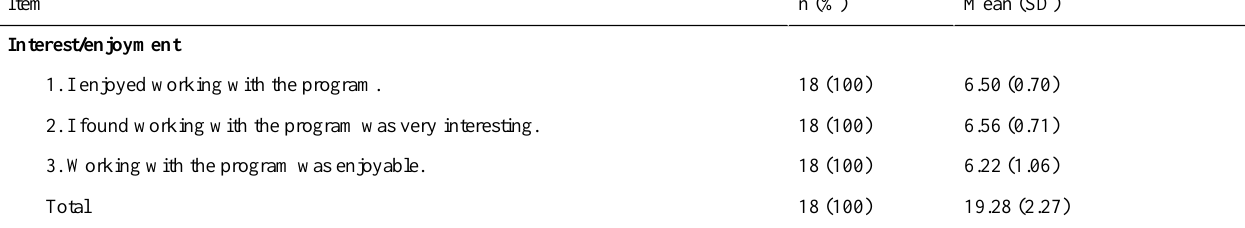
Table 1. Intrinsic motivation (KIM a ) scores for cochlear implant users (N=18).